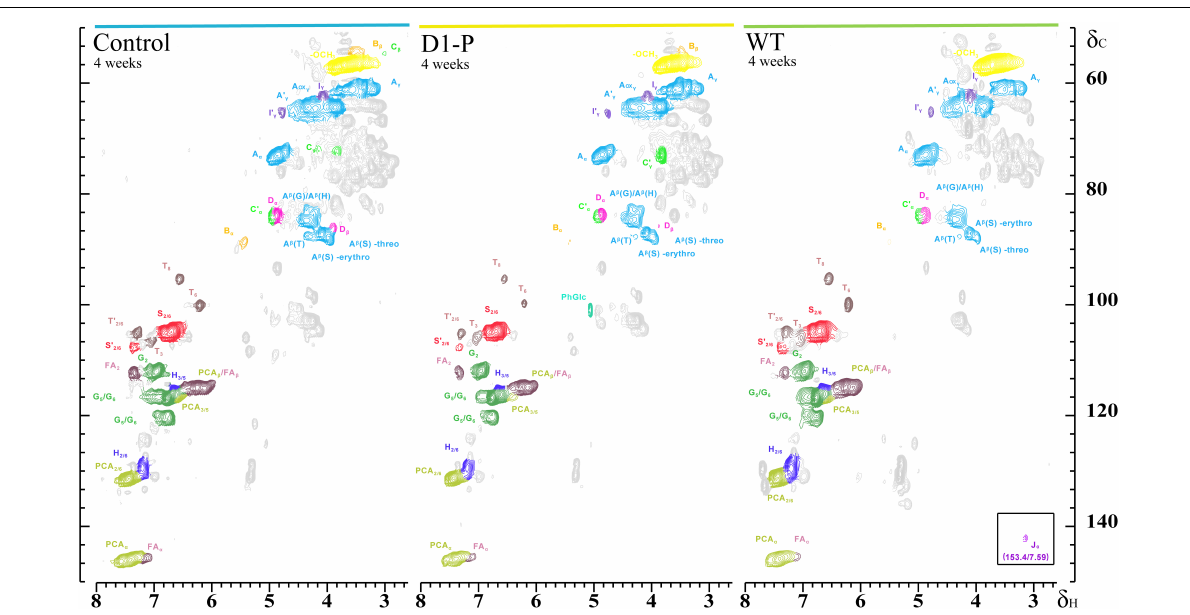
FIGURE 4 | Side chain ( δ C/ δ H 50-90/2.5-5.8) and aromatic/unsaturated ( δ C/ δ H 90-155/5.5-8.0) regions in the 2D HSQC NMR spectra of isolated CEL (left), isolated DCEL (middle), and of the isolated WCEL